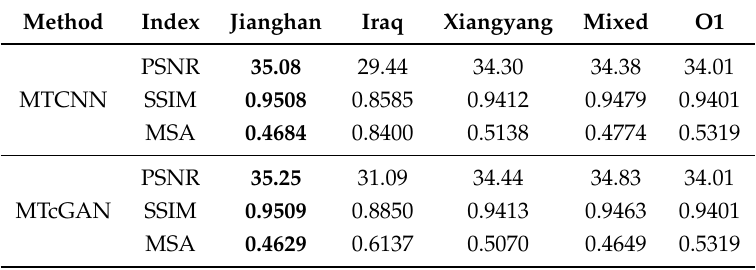
Table 4. Simulation accuracy of MTCNN and MTcGAN with different training samples in Case